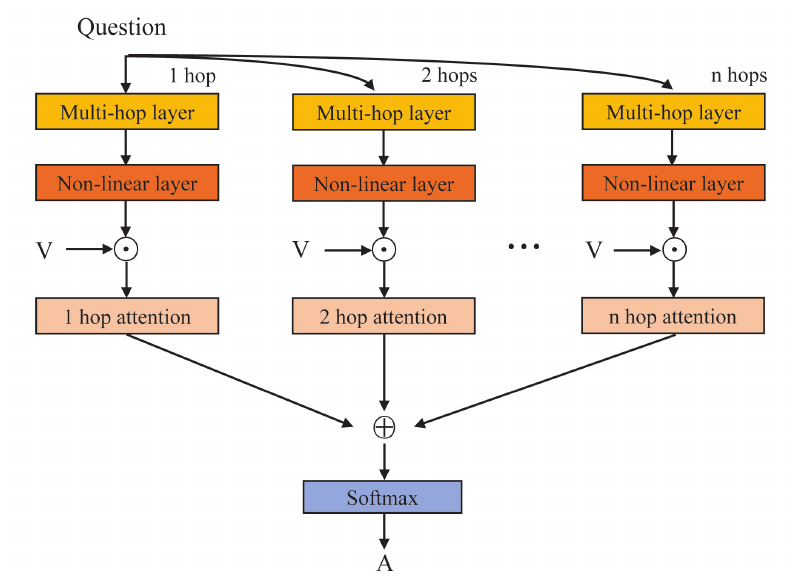
Figure 3. The structure of our multi-hop attention layer. ⊕ denotes add operation and (cid:12) denotes matrix